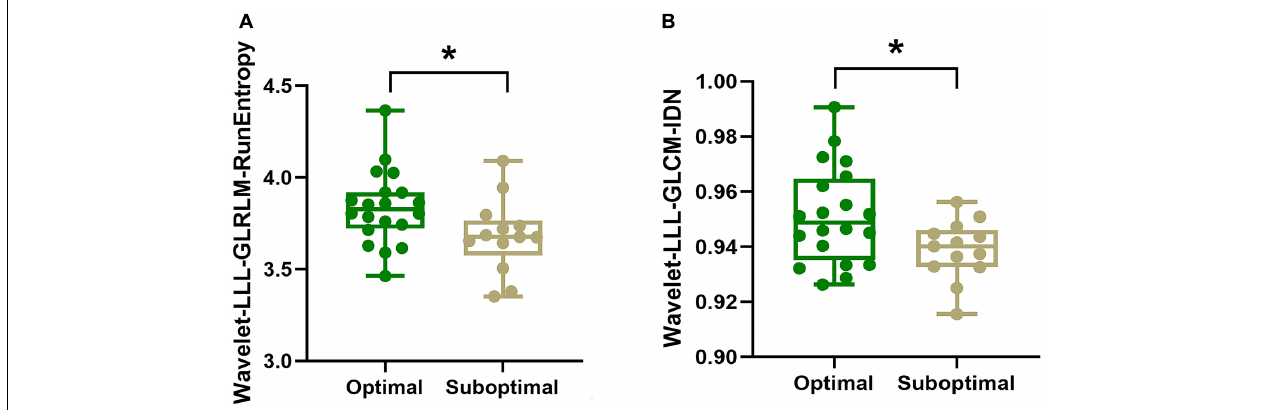
FIGURE 3 | Intergroup comparisons of radiomics features using Mann-Whitney U test. As shown in panels (A,B) , respectively. The values of Wavelet-LLL-GLRLM-RunEntropy ( p = 0.036) and Wavelet-LLL-GLCM-IDN (Inverse Difference Normalized) ( p = 0.039) for the SN are higher in patients with optimal global motor outcome than those who had suboptimal improvement following STN-DBS surgery. In panels (A,B) , the box denotes the 25th and 75th percentiles with the horizontal line denoting the median value. * indicates p <